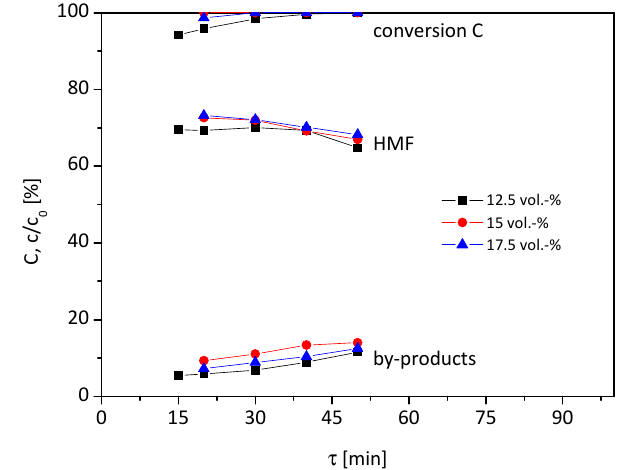
Figure 4. Influence of water content on conversion, HMF yield and by-products (0.1 M fructose, 105 °C, 12.5–17.5 vol% H 2 O in HFIP, 1.7 g Lewatit K2420 catalyst bed).